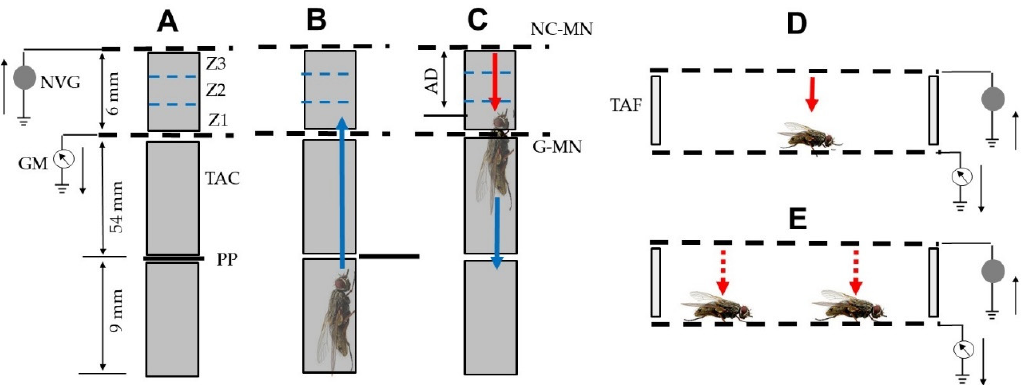
Figure 2. The experimental set-up for delivering an arc discharge to adult houseflies. ( A ) The apparatus consisted of two metal nets and three transparent acrylic cylinders (TACs) of different lengths. The upper net was linked to a pulse-type negative-voltage generator (NVG), and the lower net was linked to a grounded line. The top cylinder (6 mm in length) was placed vertically between the two metal nets, the middle cylinder (54 mm in length) was placed beneath the grounded metal net (G-MN) and on a polypropylene plate (PP), and the third cylinder (9 mm in length) was placed beneath the PP. The top cylinder was marked with lines every 2 mm to create three zones (Z1–3). ( B , C ) A climbing housefly ( B ) and its falling pathway following arc-discharge exposure ( C ). An adult housefly was placed in the lowest cylinder, and the PP was drawn out to allow the housefly to climb up the wall of the middle cylinder. The housefly was subjected to arc discharge from the negatively charged metal net (NC-MN) when it entered the upper cylinder on the G-MN and was within the arc distance (AD). ( D , E ) Another experimental set-up for exposing a housefly (or houseflies) transferred onto the G-MN. Two metal nets were separated by a transparent acrylic frame (TAF). Single ( D ) and double ( E ) CO 2 -anesthetized houseflies were transferred onto the G-MN. The black arrow represents the movement of the negative current. The solid red arrow represents the movement of electricity through arcing, and the dotted red arrow represents selective arcing to one of the two houseflies. The blue arrow represents the pathway taken as the fly climbs and falls. A galvanometer (GM) was integrated into the grounded line to detect the electric current caused by the arc-discharge